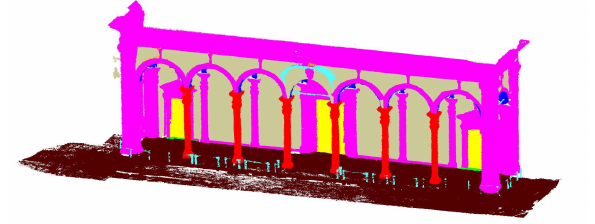
Figure 7 . a) RGB photogrammetry point cloud and b)